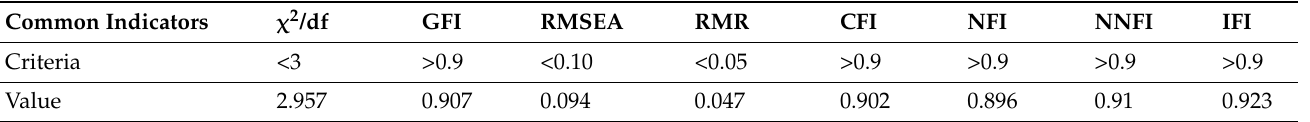
Table 5. Mediating effect.